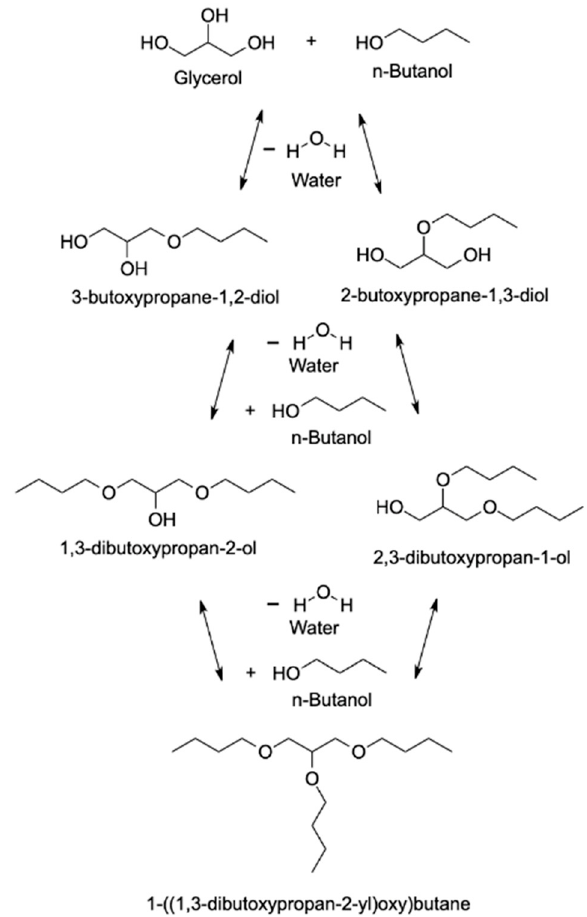
Figure 9. Reaction mechanism of glycerol etherification with n -butanol [120].